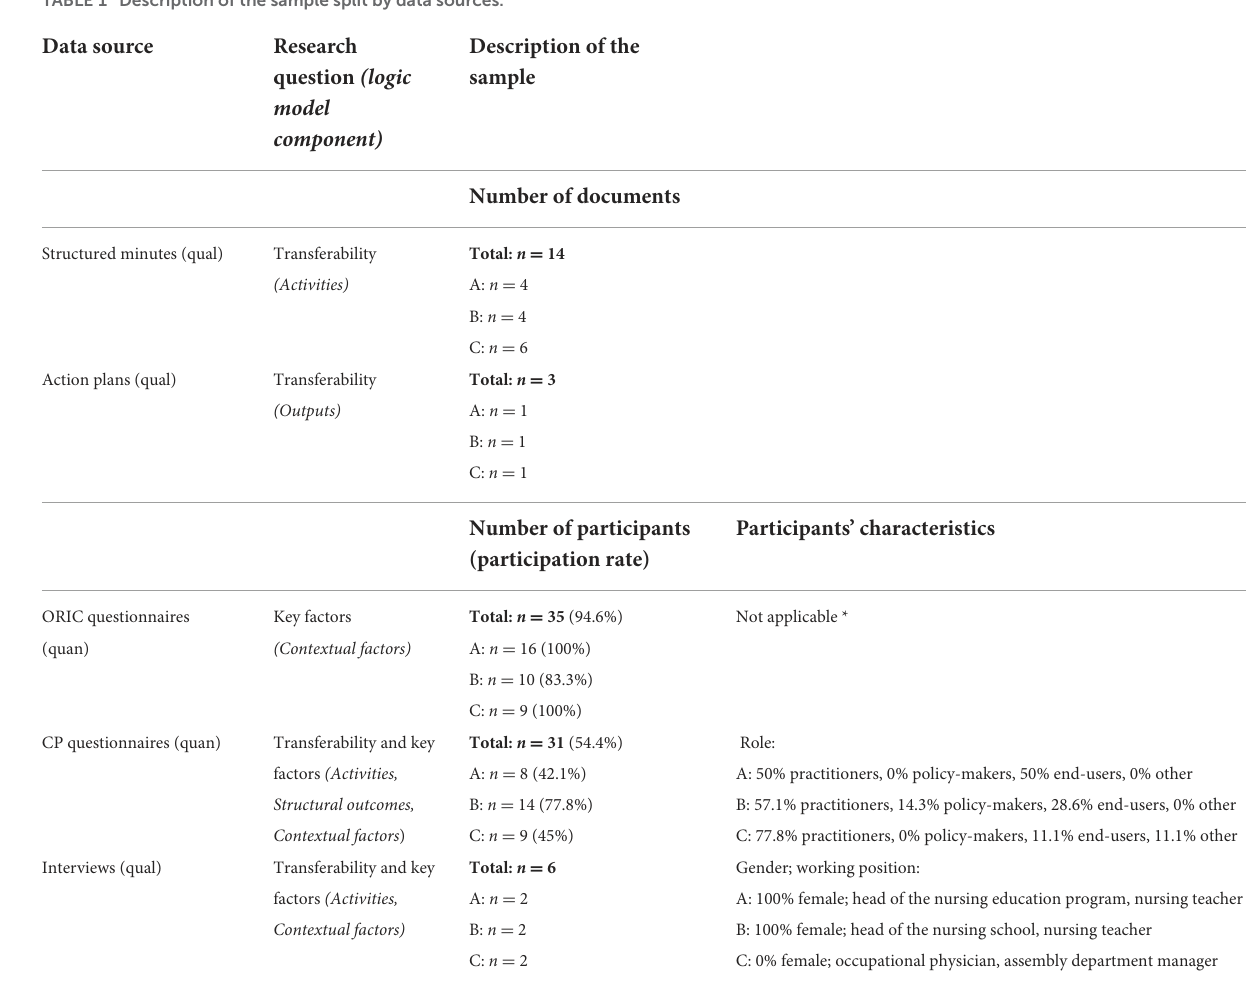
TABLE 1 Description of the sample split by data